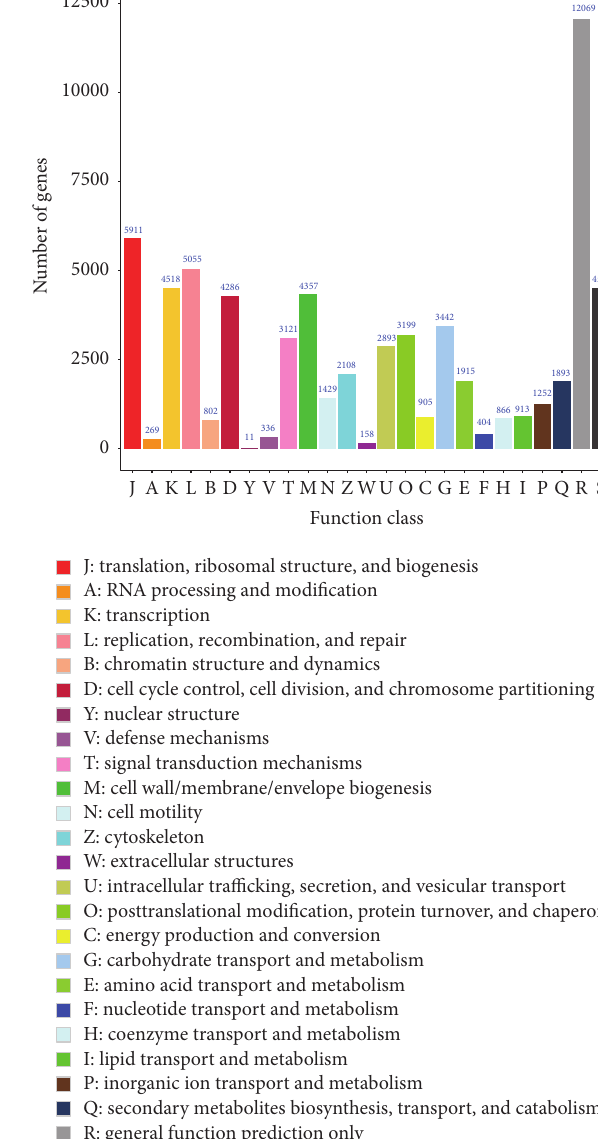
Table 4: Top 26 KEGG pathways.